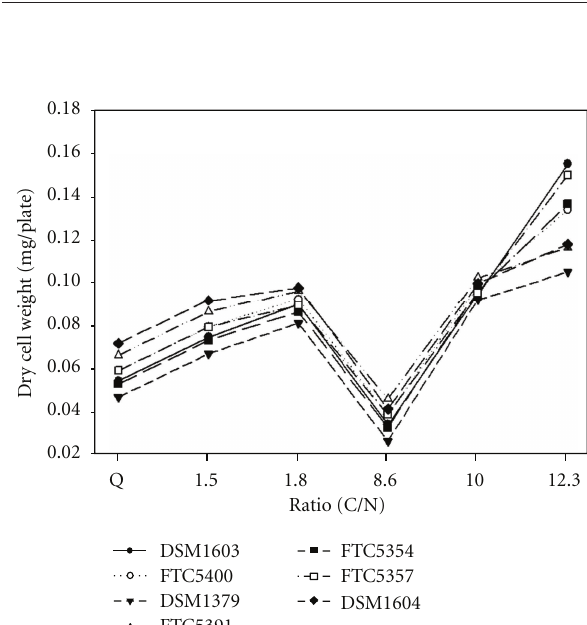
Figure 8: E ff ect of C/N ratio on the production of M. purpureus cells. Q: C/N ratio of PDA (potato dextrose agar) medium (PDA without nitrogen source), 1.5: C/N ratio of MEA (malt extract agar), 1.8: C/N ratio of IM (improved medium), 8.6: C/N ratio of Hiroi, 10: C/N ratio of PM (power medium), and 12.3: C/N ratio of Hiroi-